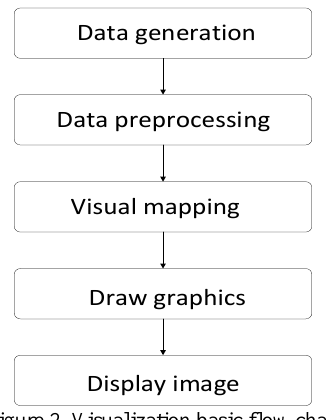
Figure 2. Visualization basic flow